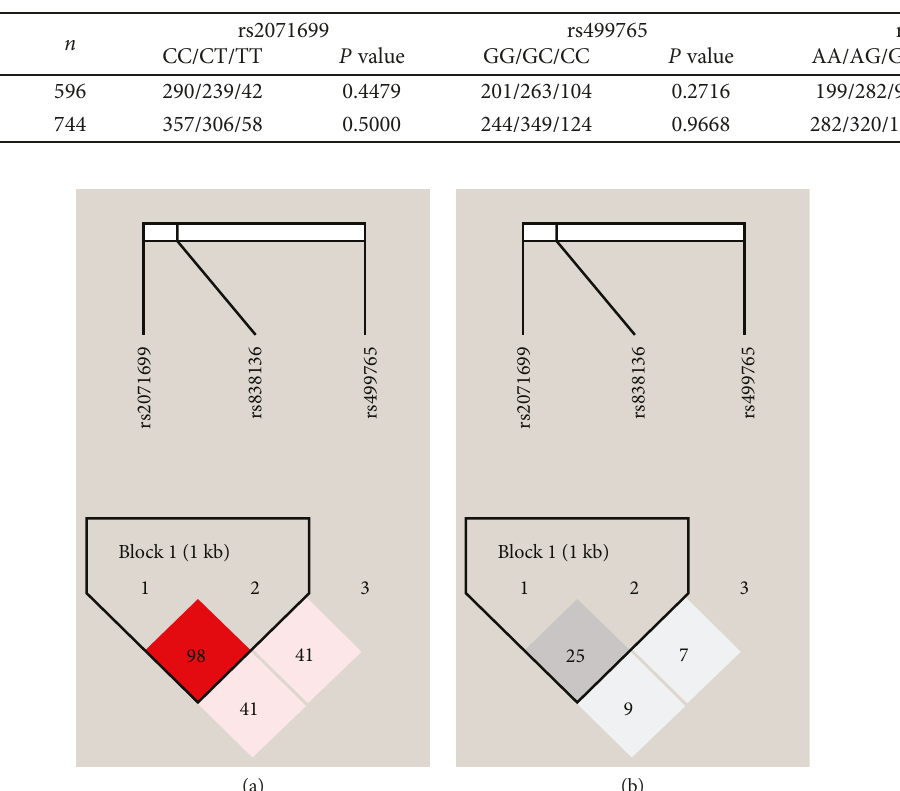
Figure 1: Linkage disequilibrium analyses for SNPs tested in the FGF21 gene region. (a) Shades of pink indicate the strength of pairwise linkage disequilibrium based on | D ′ |, and numbers represent | D ′ | which is expressed as a percentage. (b) Shades of grey indicate the strength of pairwise linkage disequilibrium based on r 2 , and numbers represent r 2 which is expressed as a